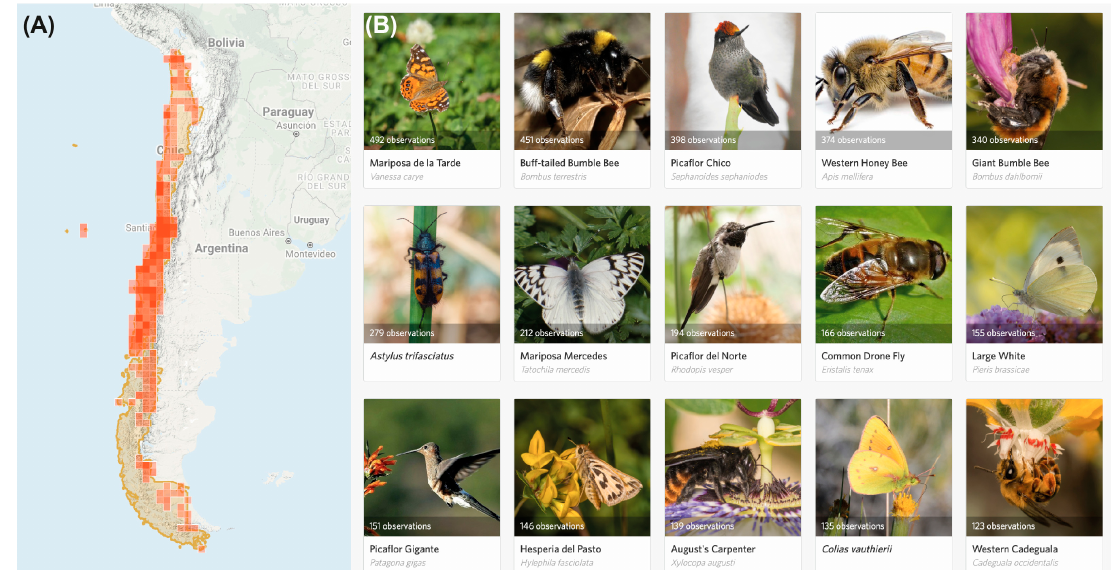
Figure 5. ( A ) iNaturalist records of pollinator species in Chile (squares indicate sites with pollinator records and color intensity is proportional to the number of records in three tones corresponding to 1, 10, and 100 records); ( B ) the most common pollinator species recorded in iNaturalist (data from the Chilean Pollination Network project, updated 15 September 2021).